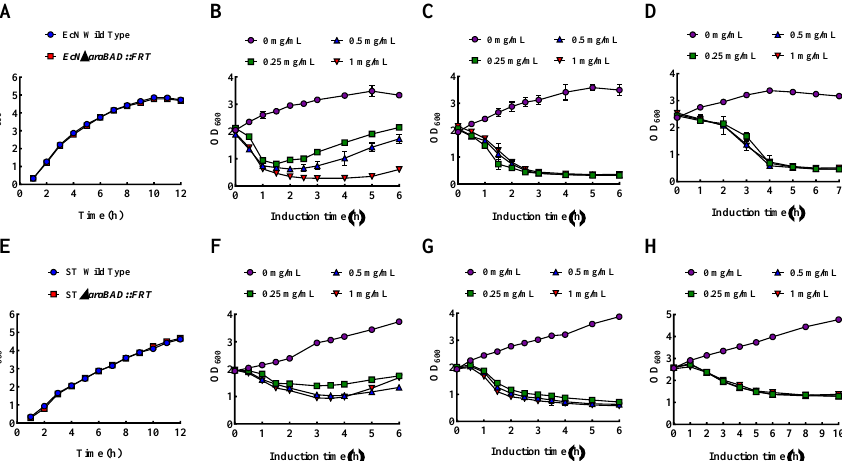
Figure 8. The growth curves and lysis curves of E. coli Nissle 1917 ∆ araBAD::FRT containing plasmid araC-ParaBAD-ID52-E and ST ∆ araBAD::FRT containing plasmid araC-ParaBAD-ID52-E engineering strain. ( A ): The growth curves of EcN WT and EcN ∆ araBAD::FRT ; ( B ) The lysis curves of EcN WT when the initial OD 600 reached 2.0; ( C ) The lysis curves of EcN ∆ araBAD::FRT when the initial OD 600 reach 2.0; ( D ) The lysis curves of EcN ∆ araBAD::FRT when the initial OD 600 reached 2.5; ( E ): The growth curves of ST WT and ST ∆ araBAD::FRT ; ( F ) The lysis curves of ST WT when the initial OD 600 reached 2.0; ( G ) The lysis curves of ST ∆ araBAD::FRT when the initial OD 600 reached 2.0; ( H ) The lysis curves of ST ∆ araBAD::FRT when the initial OD 600 reached 2.5.